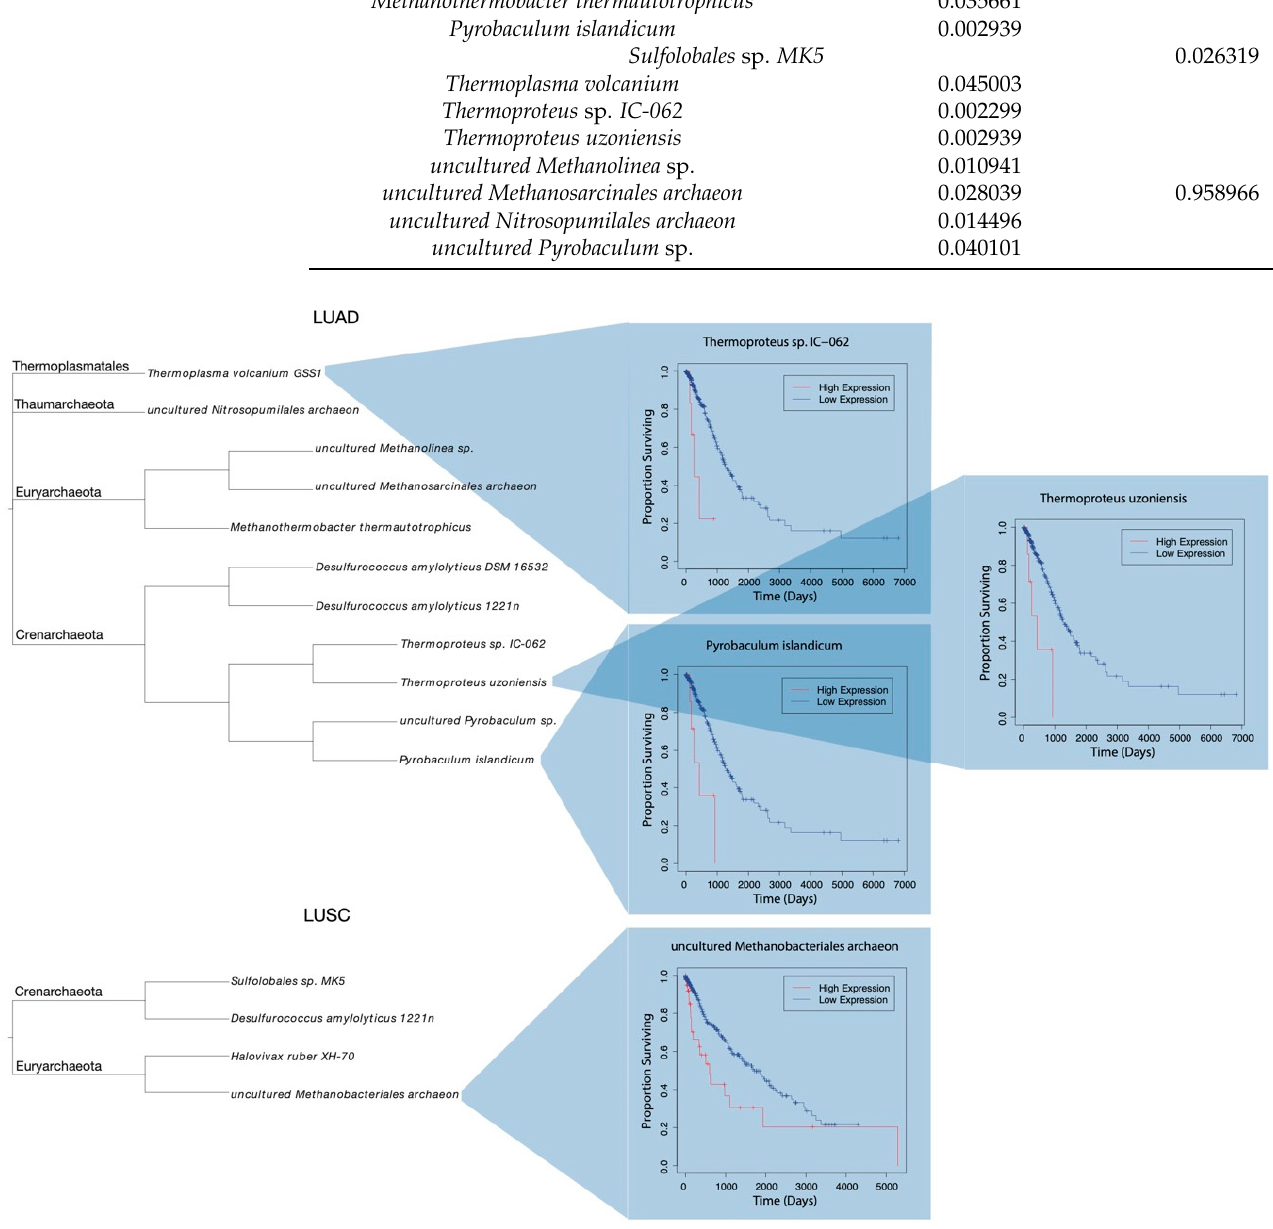
Figure 4. Phylograms of species differentially abundant among LUAD and LUSC samples, with respect to patient clinical categorization. Respective taxonomic phylums are shown. Patients were classified as “high” or “low” abundance of a species. Select Kaplan–Meier survival plots of proportion of “high” and “low” abundance patients surviving with time.